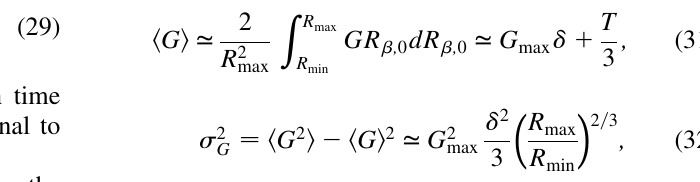
Fig. 3 that the asymptotic solution (29) is in good agree- ment with the numerical results.